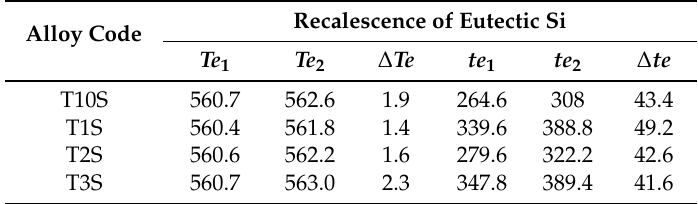
Table 4. Effect of La and Sr additions on the recalescence of the eutectic